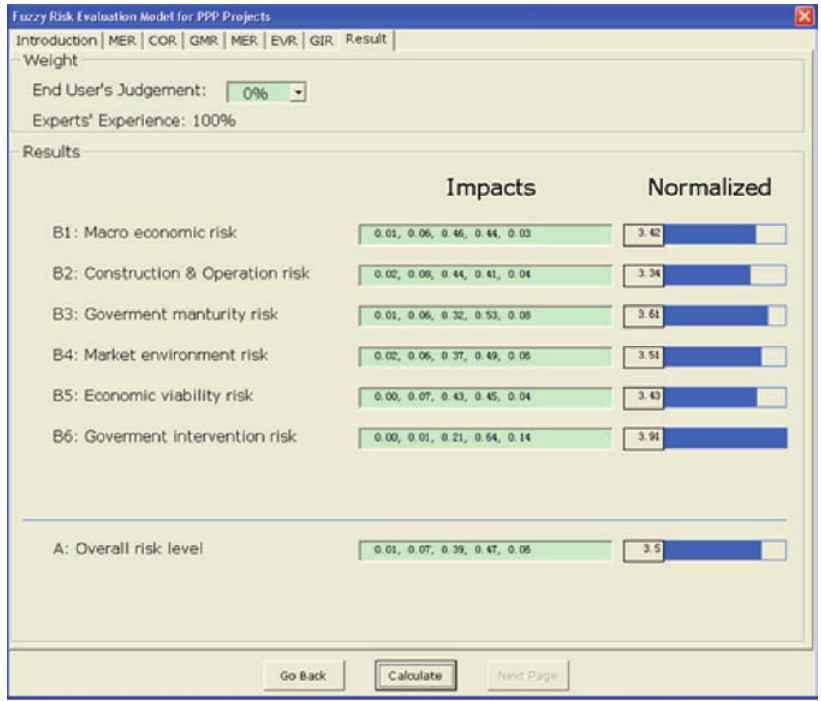
figure 5. Data output format of the risk evaluation